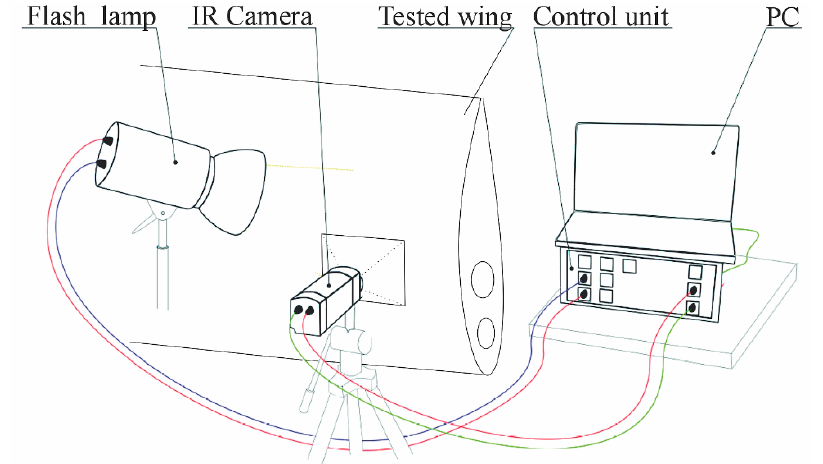
Figure 16. Pulse Thermography (PT) method experimental configuration.